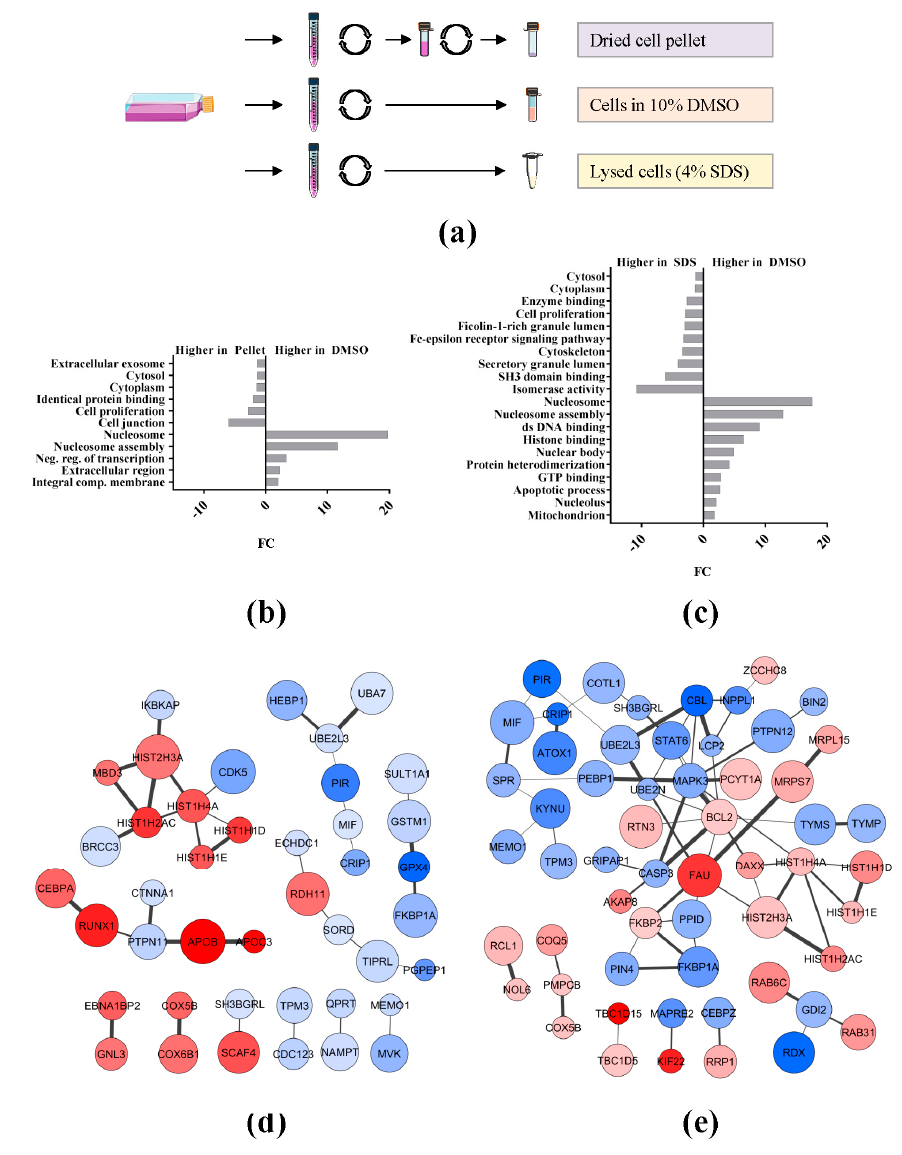
Figure 2. Proteomic outputs from THP-1 samples differently preserved. ( a ) Experimental design including the three preservation methodologies of the cell line proteome: as a dried pellet (pellet), in freezing media containing fetal bovine serum (FBS) and dimethyl sulfoxide (DMSO) and as a cell lysate in 4% sodium dodecyl sulfate (SDS); ( b , c ) Enrichment analysis of GO terms by the a GO tool software (GO slim search mode) using the significantly regulated proteins observed in the DMSO vs. pellet and in the DMSO vs. SDS comparisons, respectively; ( d , e ) Protein clusters identified with STRING using regulated proteins from the DMSO vs. pellet and from the DMSO vs. SDS comparisons, respectively. Protein nodes are colored with red when they are more abundant in the DMSO condition and with blue when they are more abundant in the pellet or SDS conditions. Increased size of nodes reflects a more significant p -value and thicker edge width represents a more confident interaction from STRING analysis.